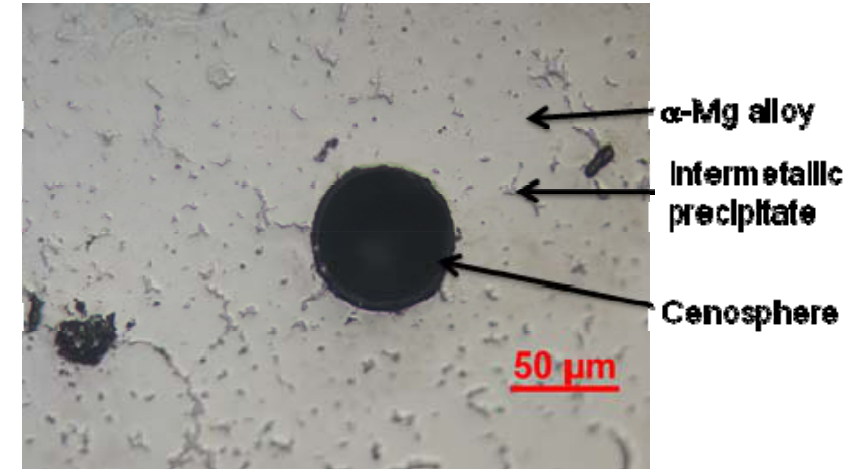
Figure 6. Optical micrograph of AZ91D/fly ash cenosphere composite showing intermetallic precipitates in primary magnesium